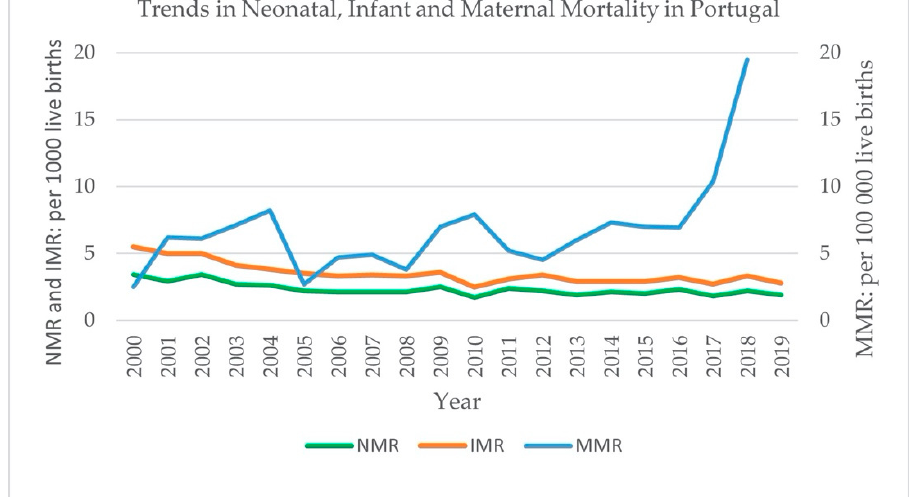
Figure 1. Trends in neonatal, infant and maternal mortality in Portugal from 2000 to 2019. NMR (neonatal mortality rate) and IMR (infant mortality rate) are calculated per 1000 live births, as shown on the primary vertical axis, and MMR (maternal mortality ratio) is calculated per 100,000 live births, as shown on the secondary vertical axis. Source: based on data retrieved from the National Institute of Statistics portal [26] and Pordata